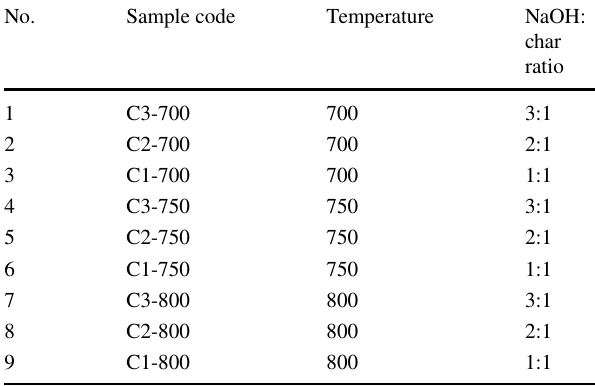
Table 2 Prepared activated carbon